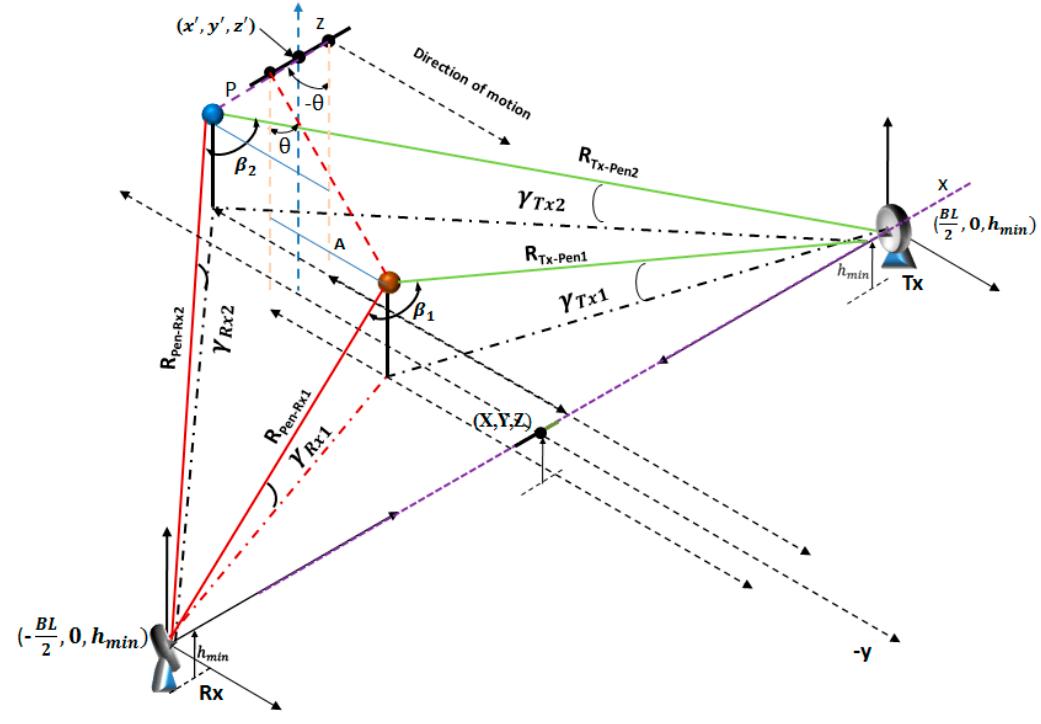
Figure 7. Two forward and backward-shifted pendulums oscillating in the FSR system.